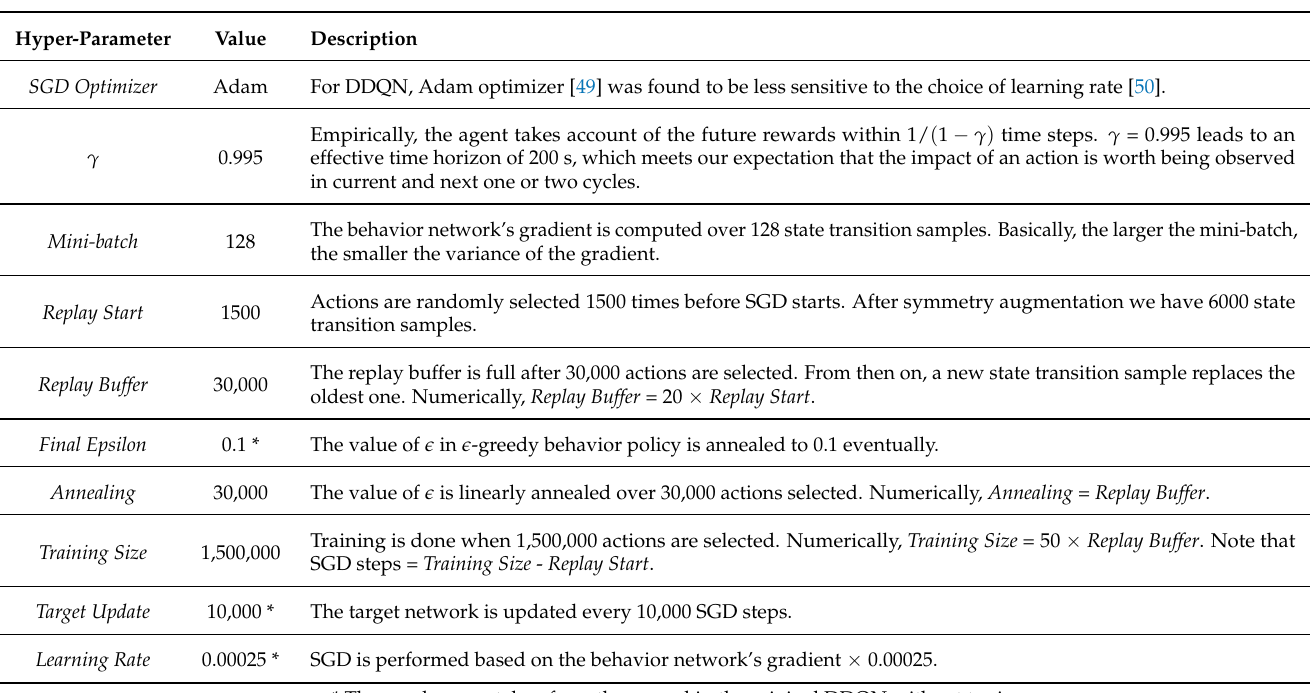
Table 2. Hyper-parameters of